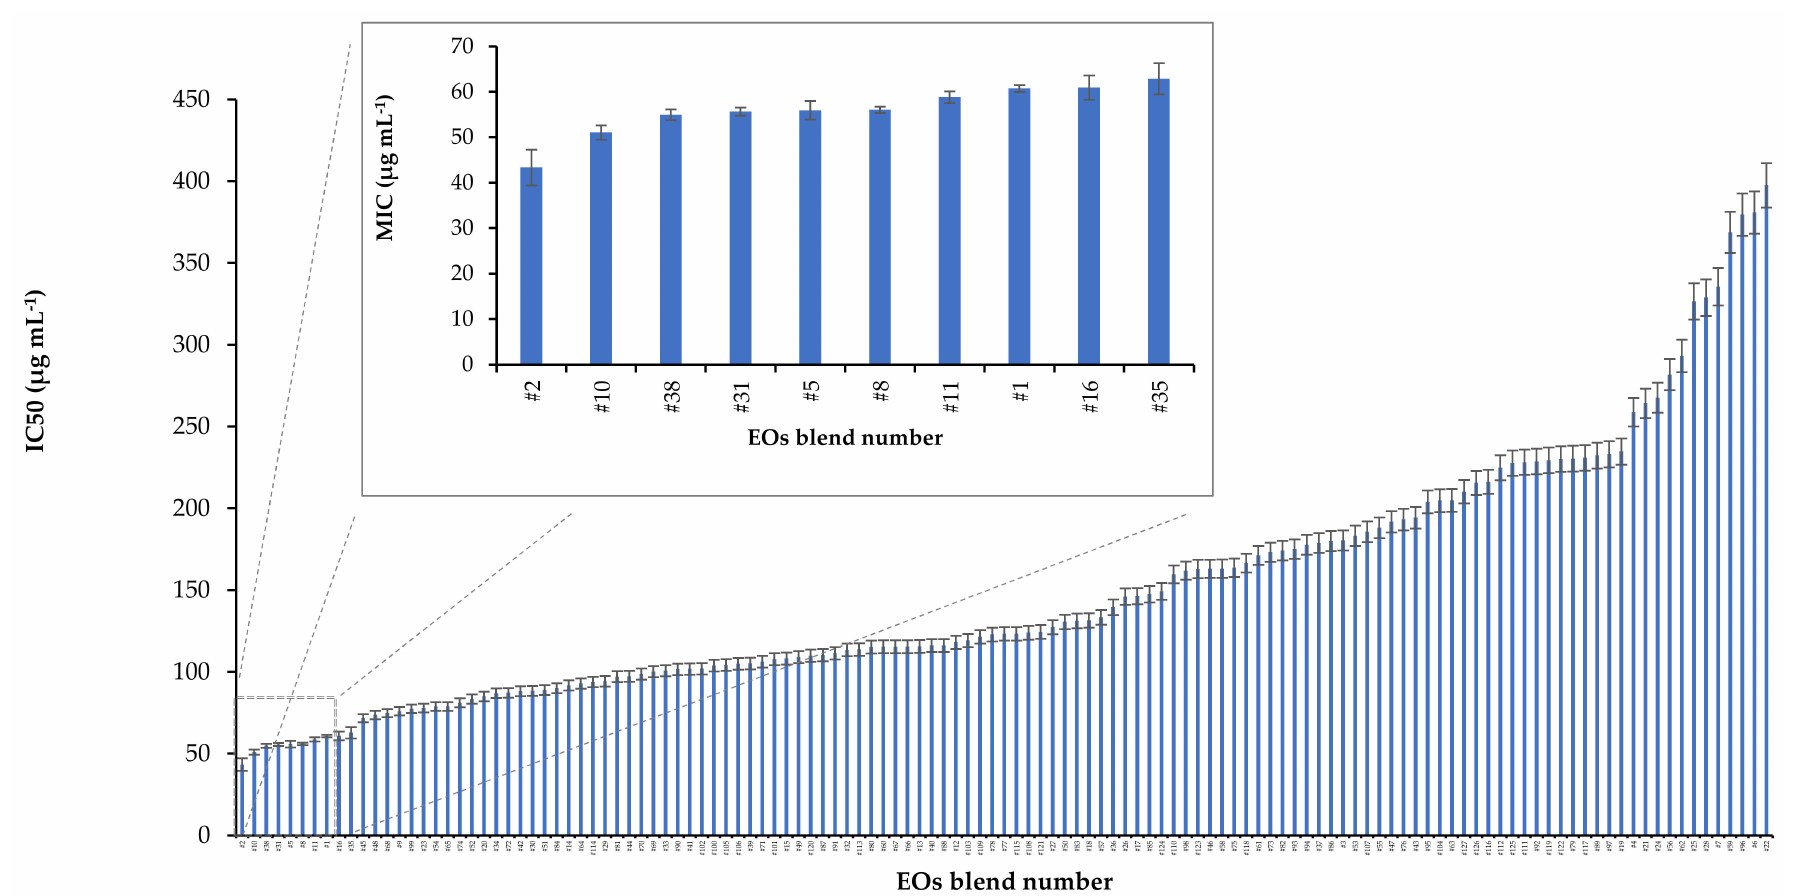
Figure 1. Inhibitory concentrations (IC 50 in µ g mL − 1 ) of 127 blends of EOs from seven Greek aromatic-medicinal plants against the fish pathogen Aeromonas veronii bv. sobria. The inset highlights the IC 50 values of the top-10, most effective blends. The composition of the seven EOs in each blend is shown in Table S2 (Supplementary